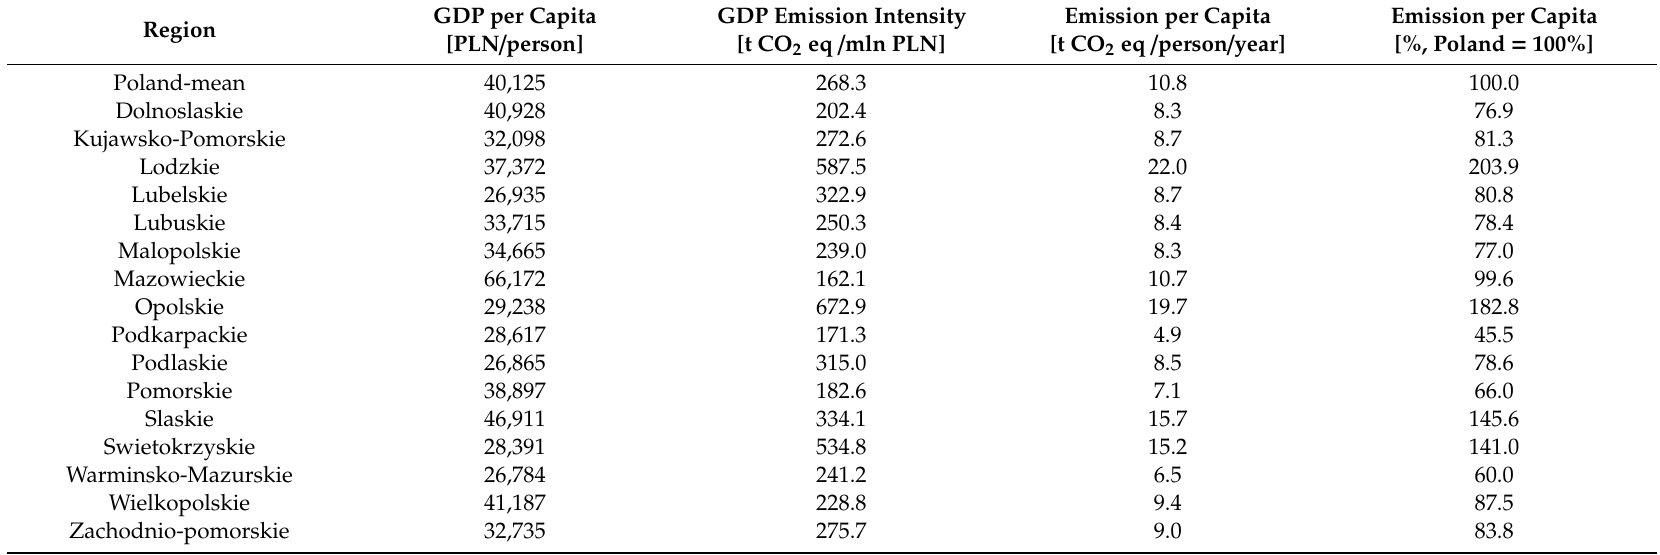
Table 2. Indicators related to greenhouse gases (GHG) emission intensity across Polish regions in 2017. Source: Data from [58] and own calculation.